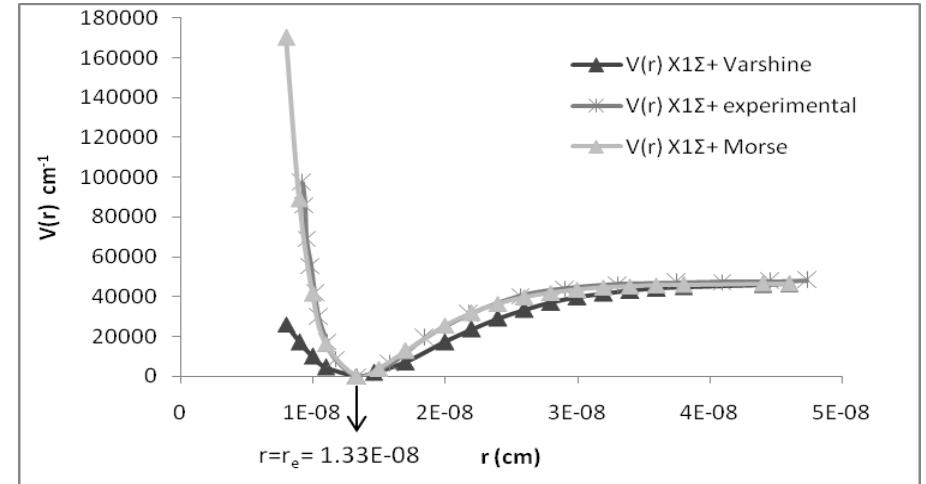
Fig.1: Theoretical potential calculated by Morse and Varshine function compare with the experimental curves for ground state X 1 Σ +